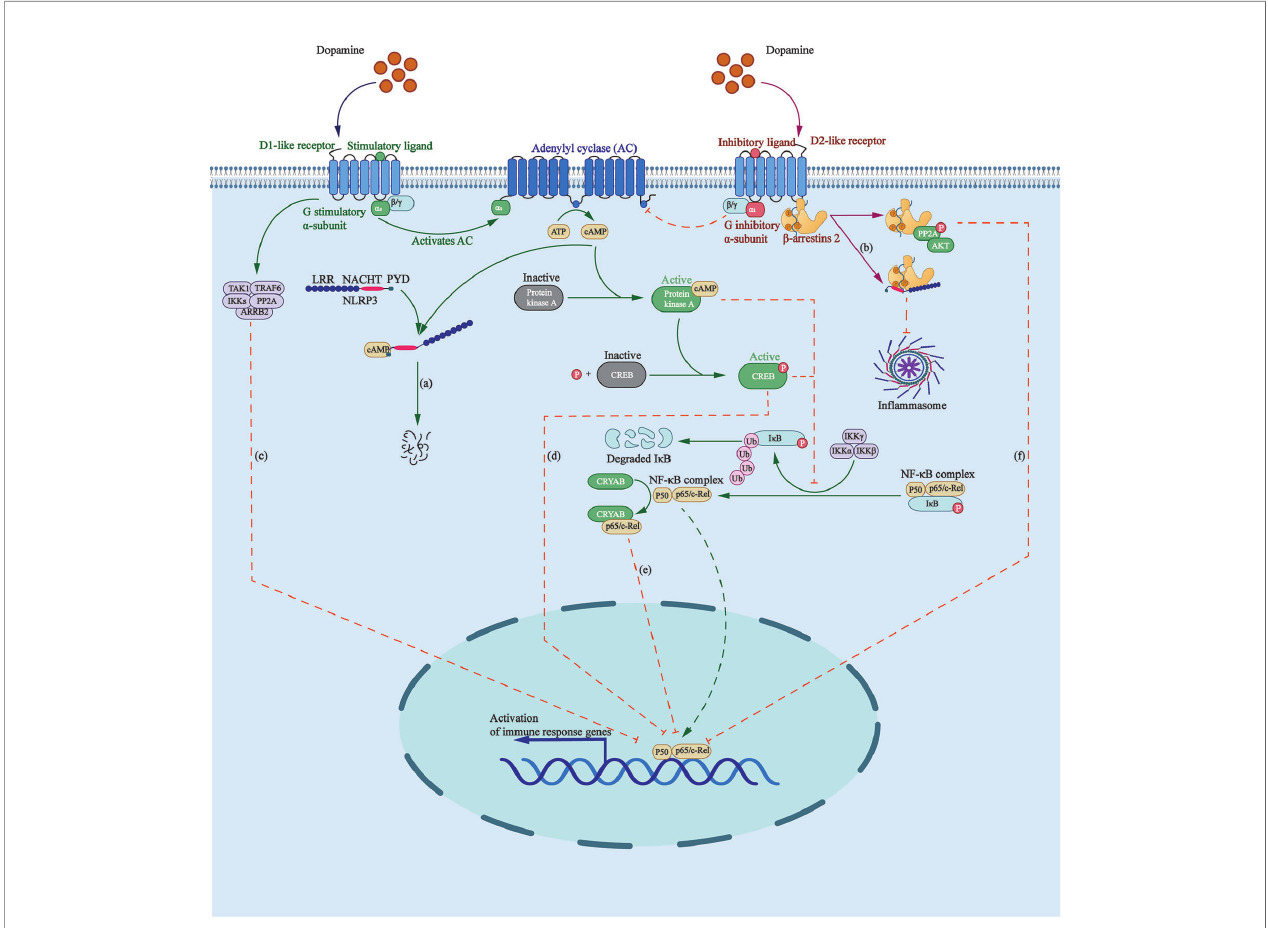
FIGURE 1 | Roles that dopamine receptors play in regulating in fl ammasome formation as well as NF- k B pathway. (A) Elevated cAMP, induced by D1 like receptors, directly binds to NLRP3, triggering the ubiquitination of NLRP3 NACHT and LRR domains with K48 ubiquitin chains by MARCH7, targeting NLRP3 to autophagy- mediated degradation. (B) b -arrestin2 recruited by D2R binds to NLRP3 to repress its activation. (C) D5R directly recruits TRAF6, ARRB2, TAK1, IKKs, and PP2A to form a multiprotein complex, impairing TRAF6-mediated activation of NF- k B. (D) Activated cAMP/PKA/CREB signaling inhibits p65/RelA and p50 activation as